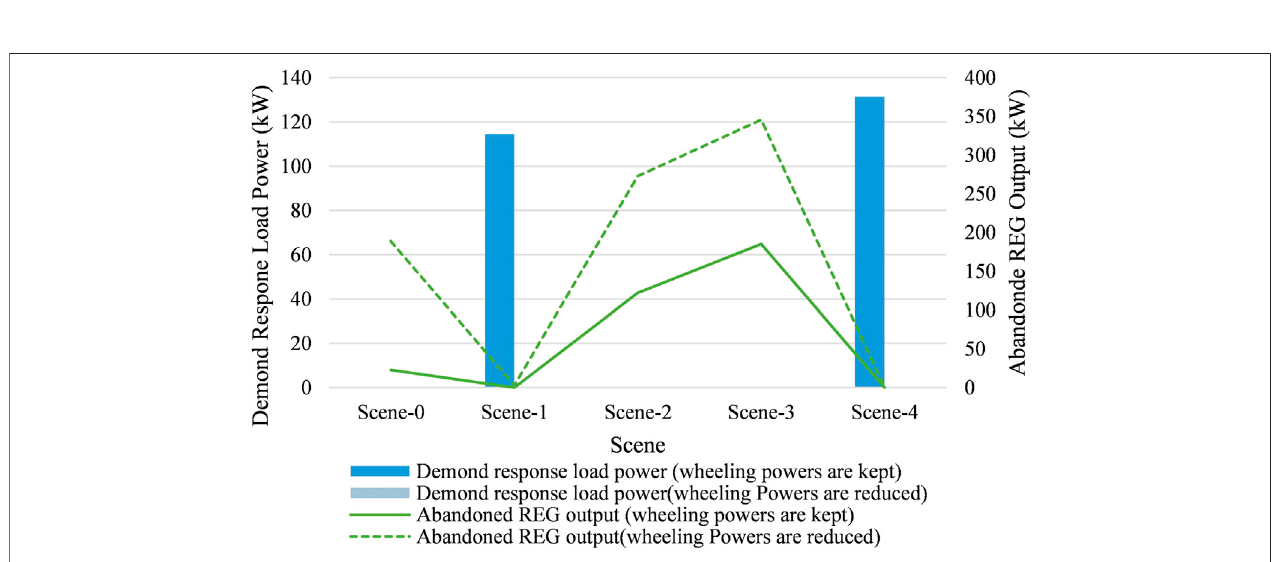
FIGURE 5 | Demand response and abandonment output of REG for Cell-2 under original wheeling power and reduced wheeling power conditions.